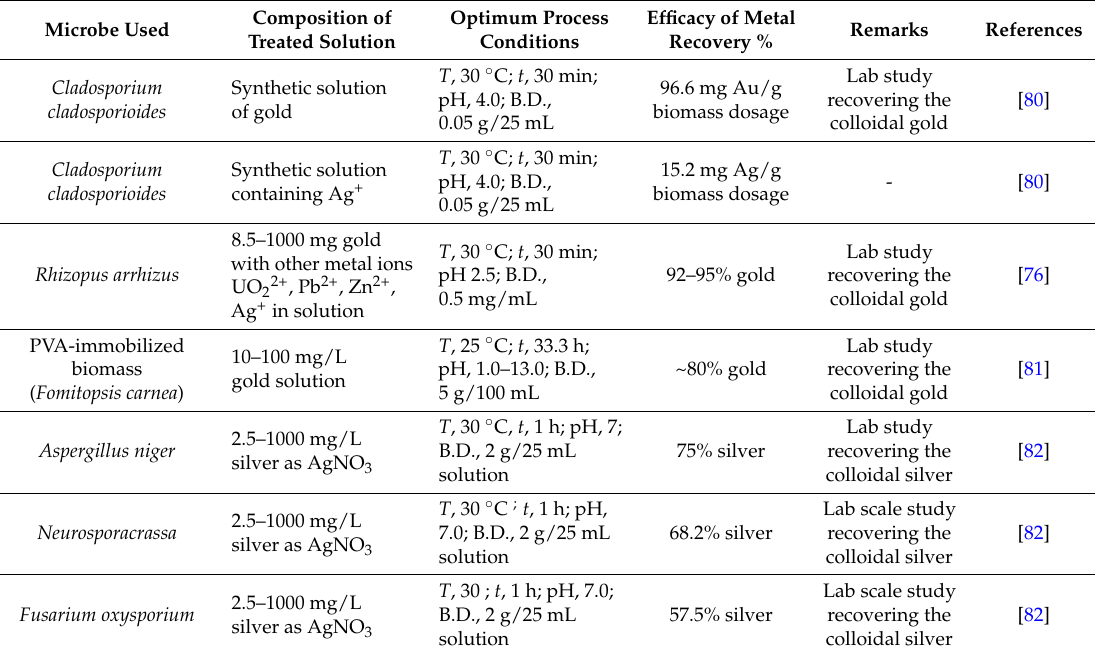
Table 3. A summary of the biosorption studies of gold and silver by dead biomass of fungi and yeast ( T = temperature, t = contact time, B.D. = biosorbent